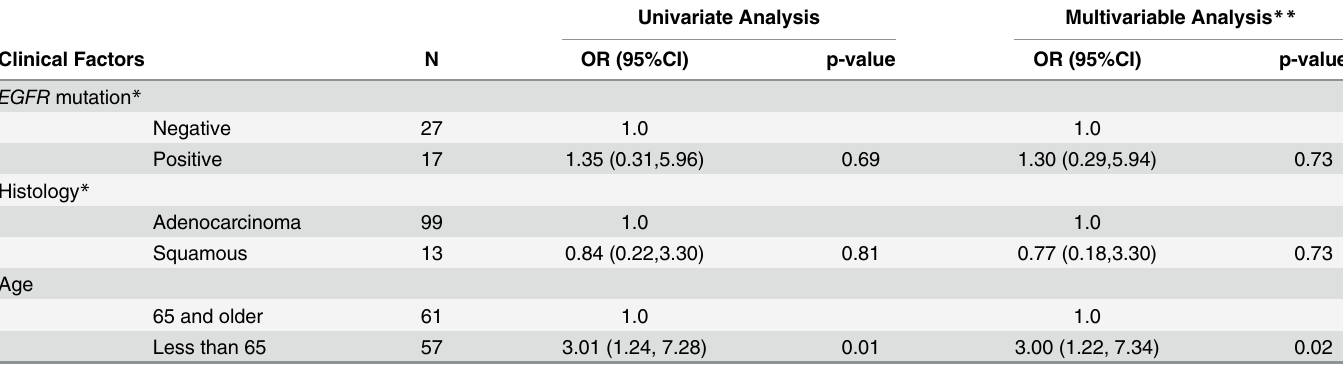
Table 4. Univariate and multivariable logistic regression analysis for association of clinical factors with presence of brain metastases at baseline.